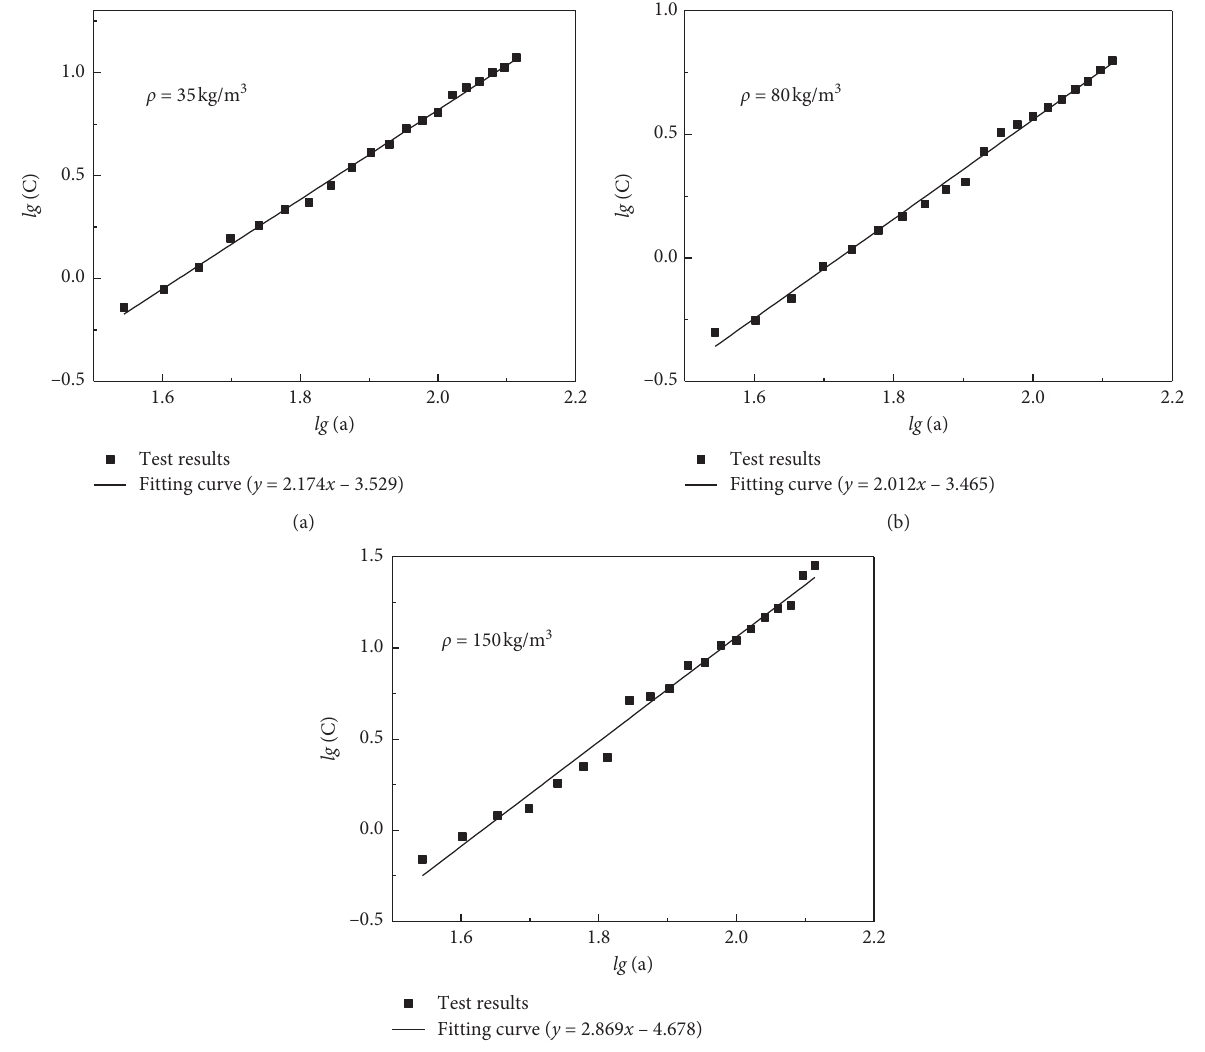
Figure 9: The values of m determined under different foam core